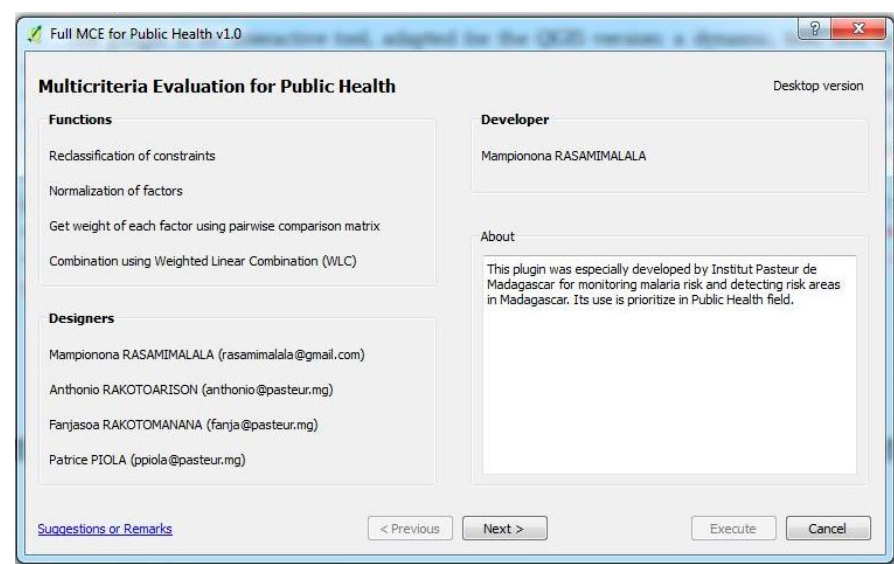
Figure 7. Interface of the developed multi-criteria evaluation (MCE) plugin.